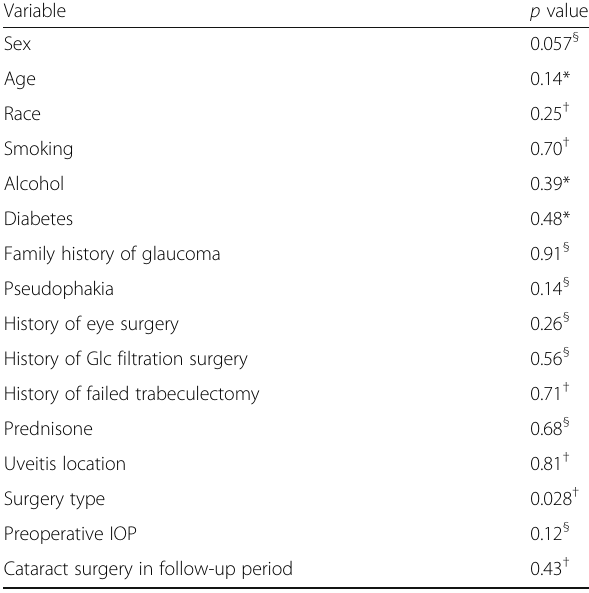
Table 7 Univariate predictors of